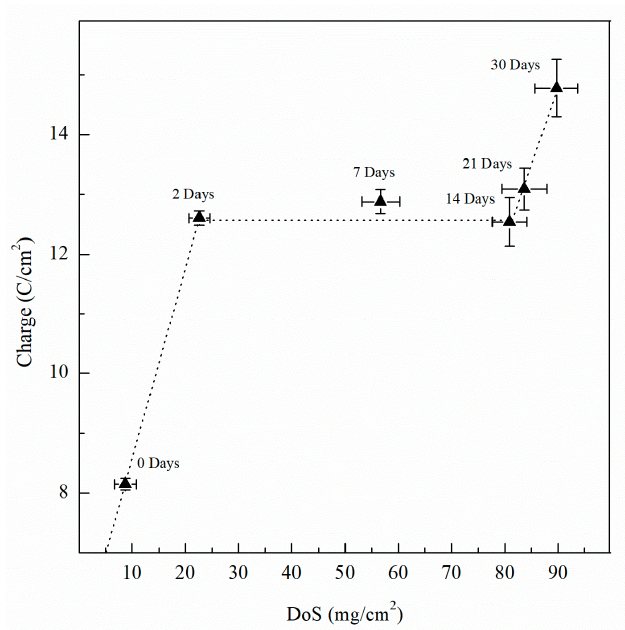
Figure 18. Charge calculated from current transient data for AA5083 sensitized at 150 °C for up to 30 days. Error bars represent the standard deviation from the mean.